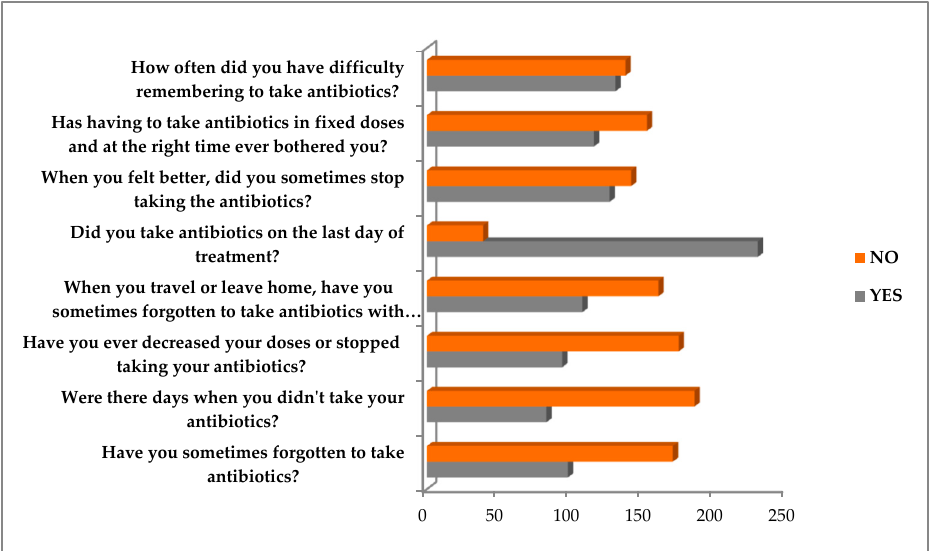
Figure 1. Distribution of the Morisky scale score based on the questions and answers.